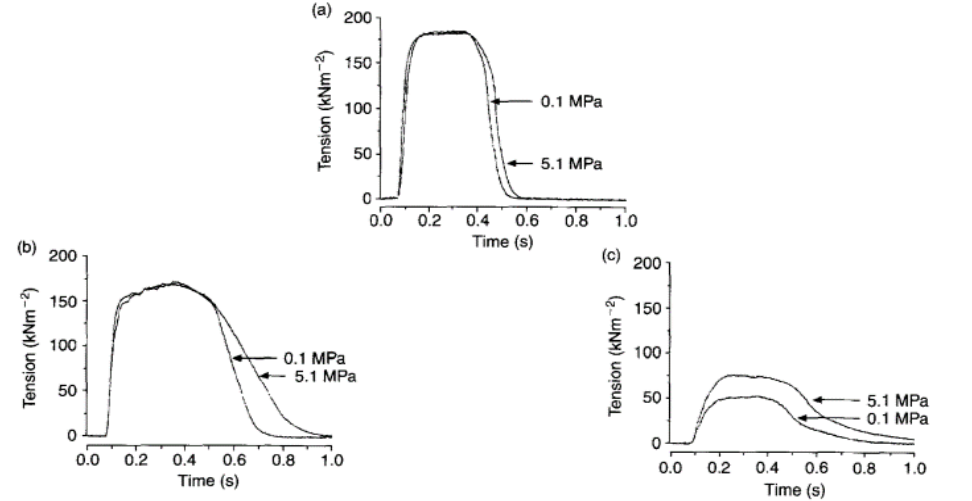
Figure 13. Pressure effects on tetanic contractions at different stages of fatigue (Temp 10 °C). ( a ). before fatigue and ( b ) after 5 min into fatigue: high pressure caused a slight decline in tetanic tension. ( c ) After 10 min into fatigue, tension declined to 30%, and pressure potentiated the tension (Vawda et al., 1996, [12]).